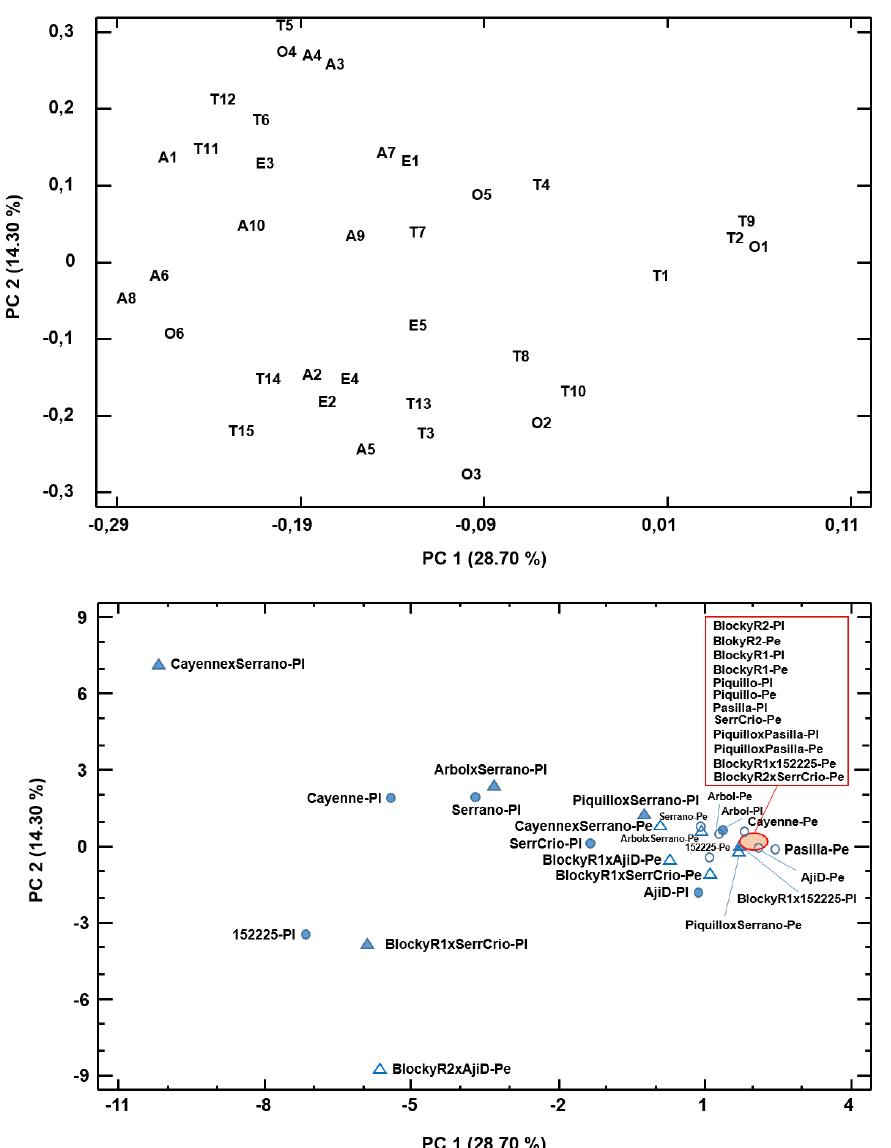
Figure 3. Principal component analysis (PCA) plots of the volatiles identified ( upper ) and the parent and hybrid accessions evaluated, corresponding to the pericarp (Pe) and placental (Pl) tissues ( bottom ). Accession and volatile abbreviations correspond to those indicated in Tables 1 and 2, respectively.